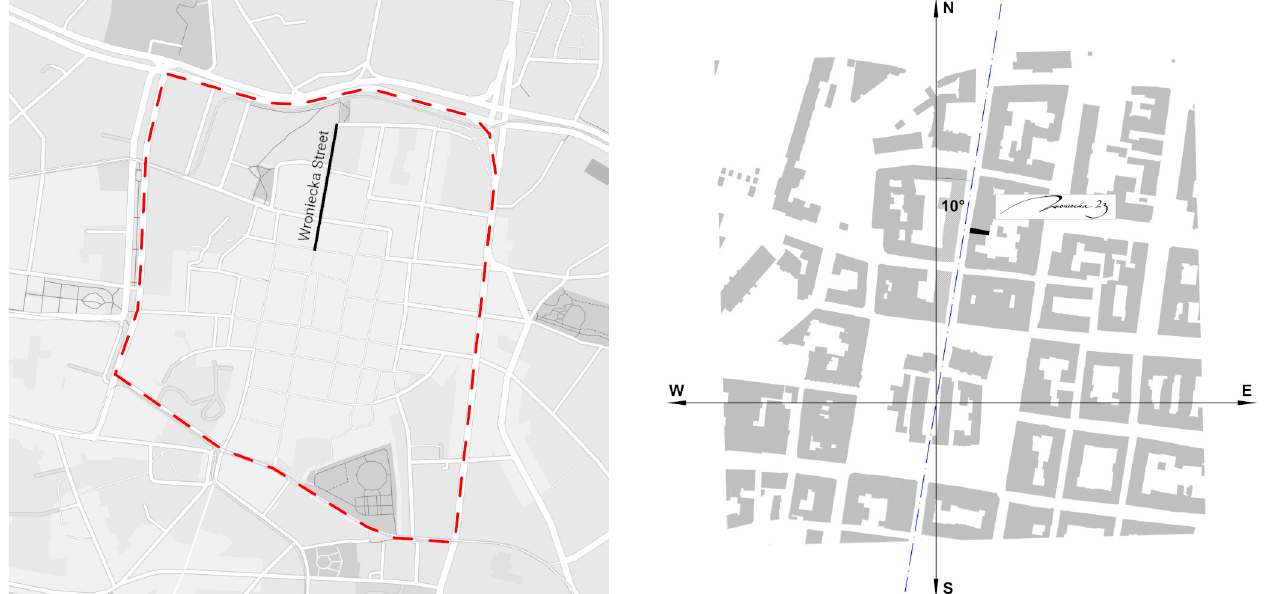
Figure 3. Area of conducted analysis: left picture: the borderline of “Old Town Culture Park” in Pozna ń ; right picture: deviation of urban grid of the Old Town in Pozna ń from the north-south axis.